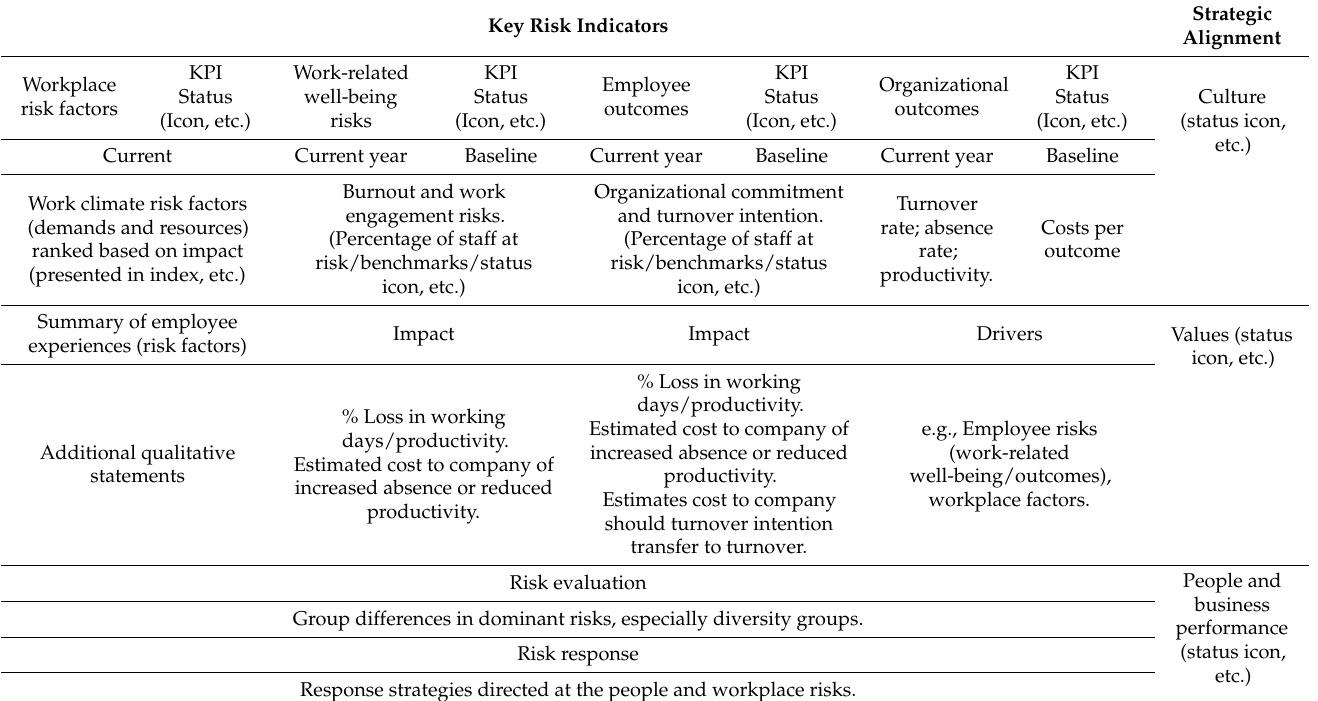
Table 6. The proposed human capital risk reporting